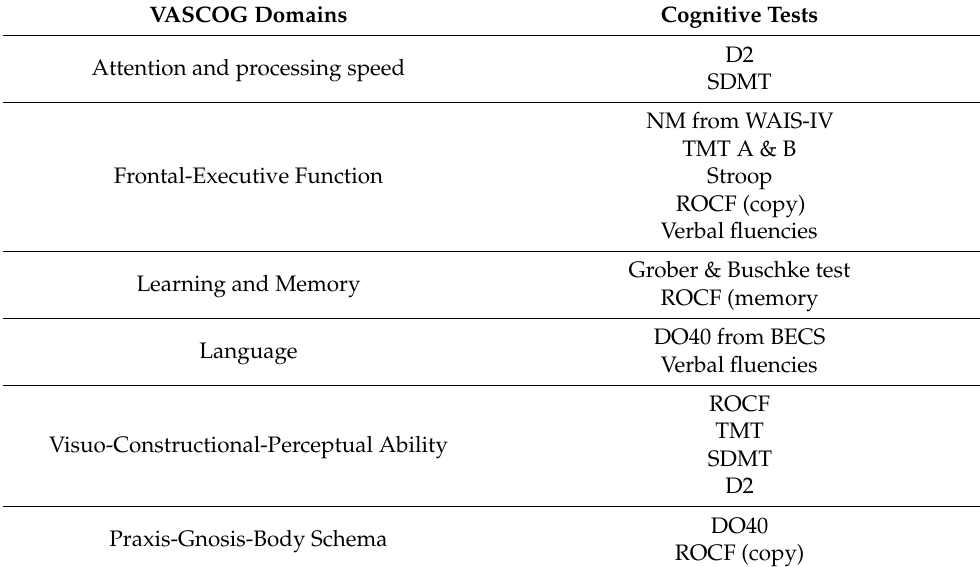
Table 1. Cognitive battery and VASCOG